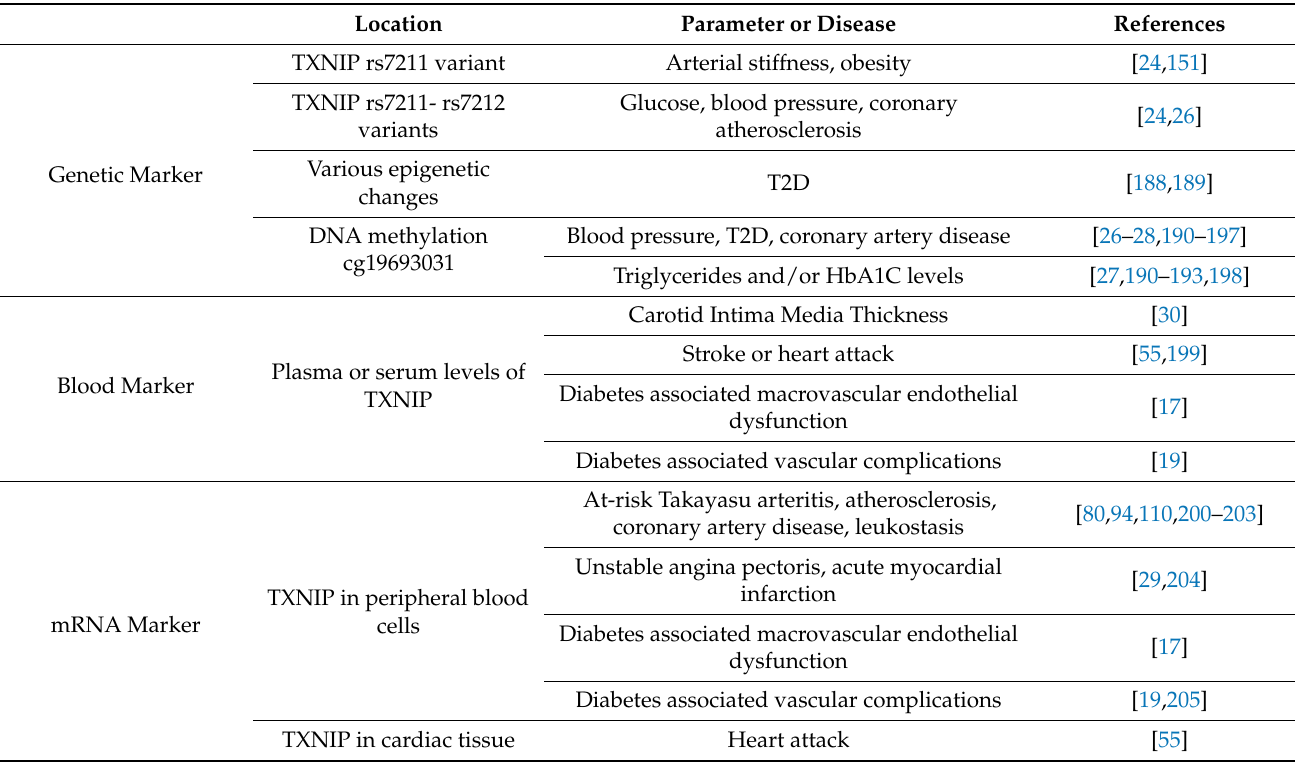
Table 2. TXNIP as a marker of cardiovascular risk and